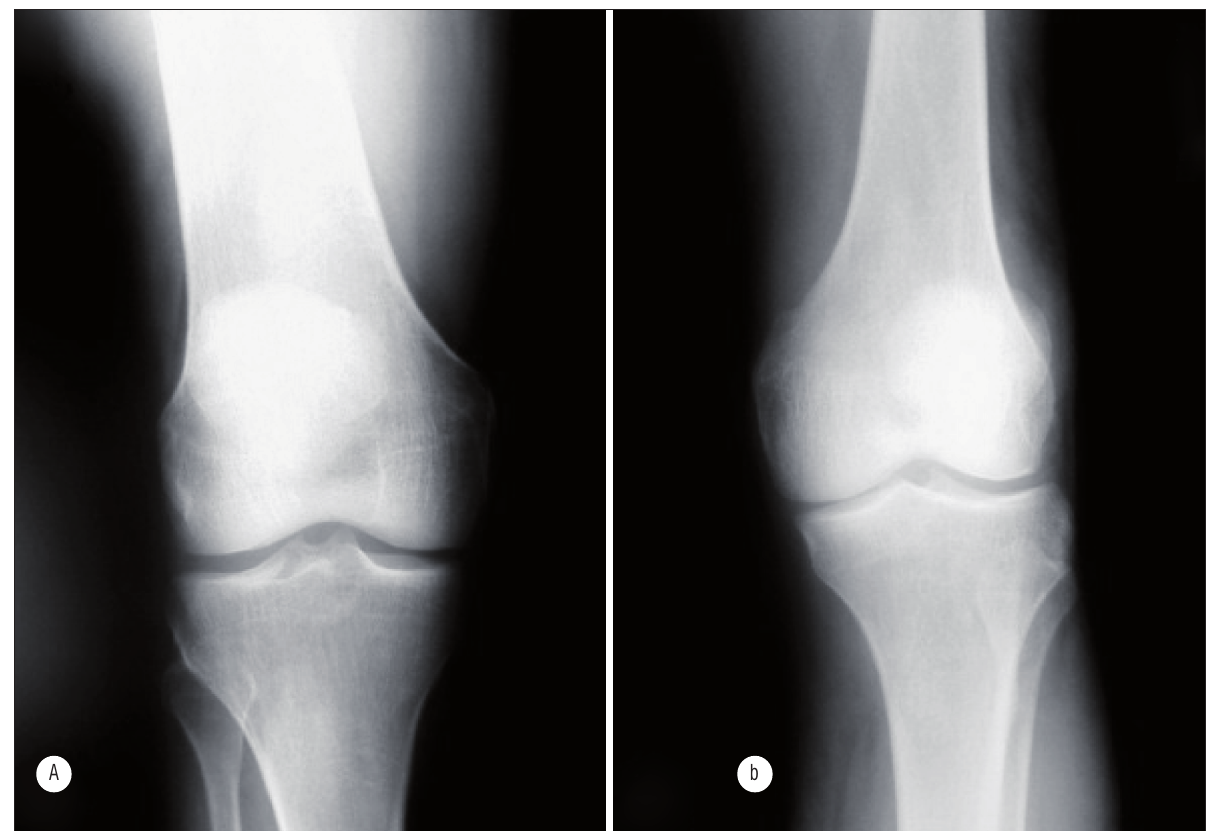
Figura 2 - Radiografias em incidência anteroposterior da articulação do joelho no membro intacto de dois indivíduos